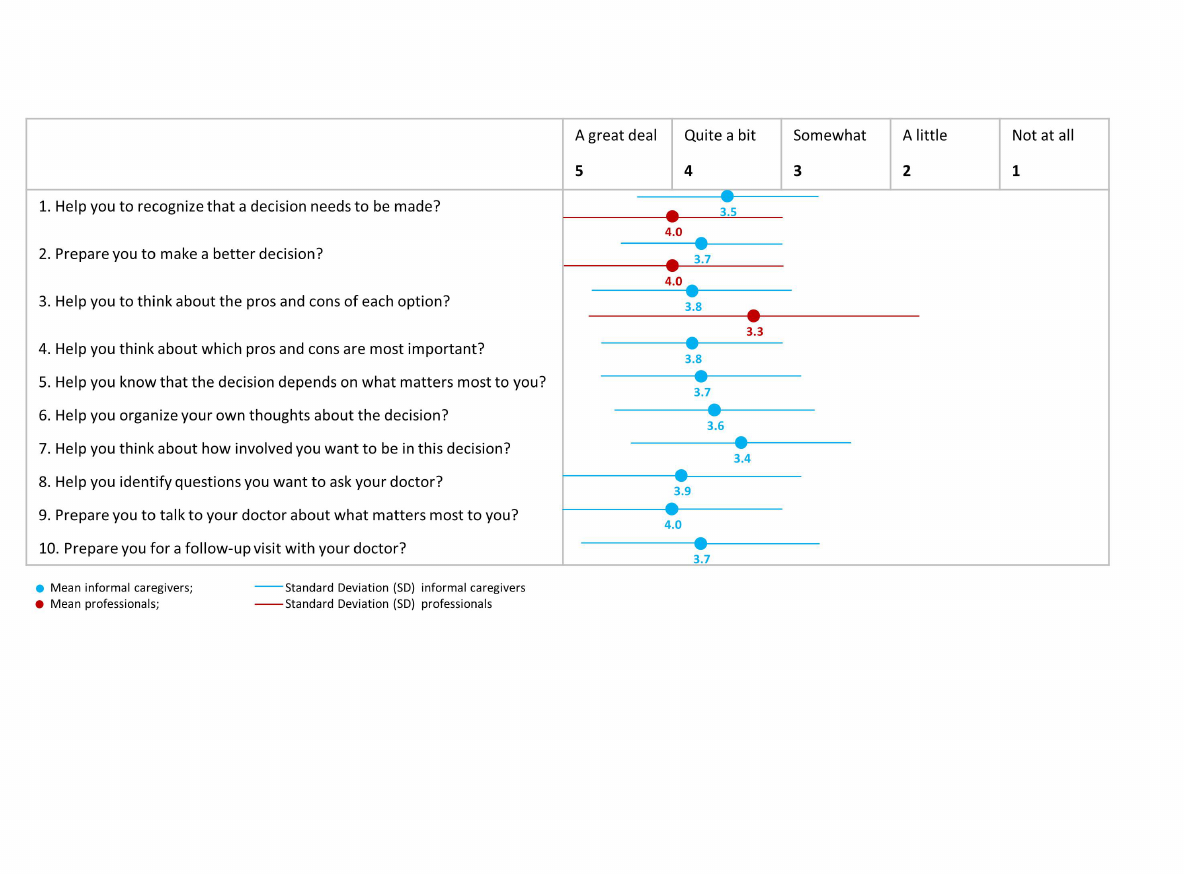
Figure 5. Preparation for decision making by the eHM-DP